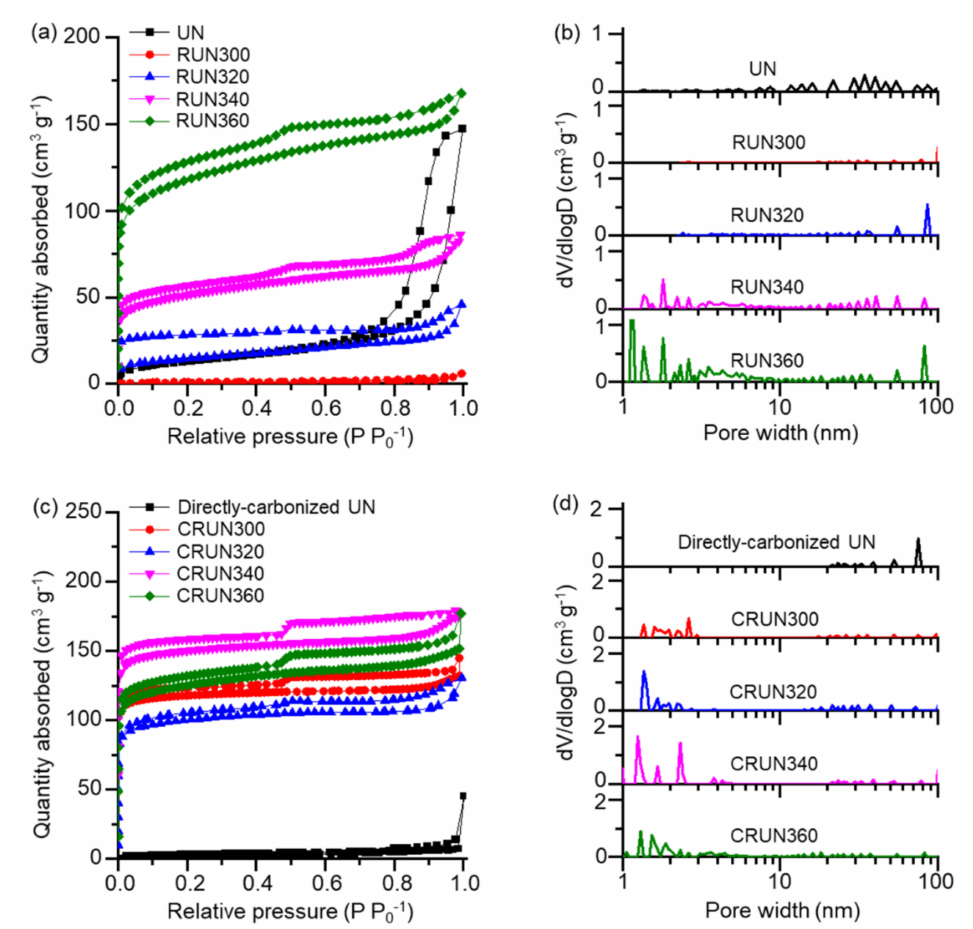
Figure 3. The change in pore characteristics in the transformation of RUNs to CRUNs. ( a ) N 2 adsorption–desorption isotherms of the RUNs and a UN. ( b ) NLDFT pore distribution curves of the RUNs and a UN. ( c ) N 2 adsorption–desorption isotherms of the CRUNs and a directly carbonized UN. ( d ) NLDFT pore distribution curves of the CRUNs and a directly carbonized